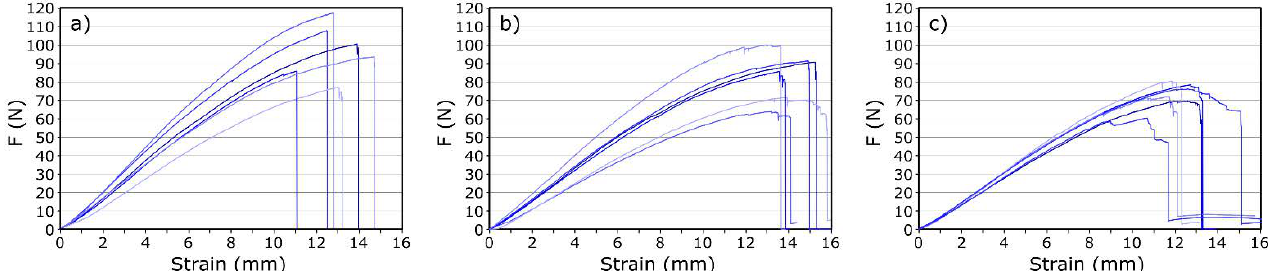
Figure 7. Stress-strain curves of three-point bending test samples for composites with: ( a ) 0; ( b ) 0.3, and ( c ) 0.5% graphene oxide (GO).